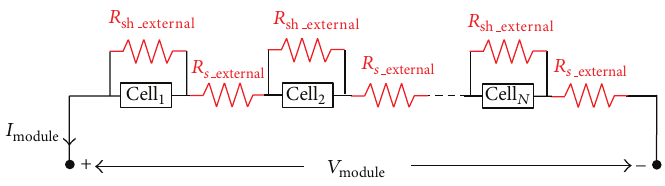
Figure 9: Equivalent electrical scheme of module.